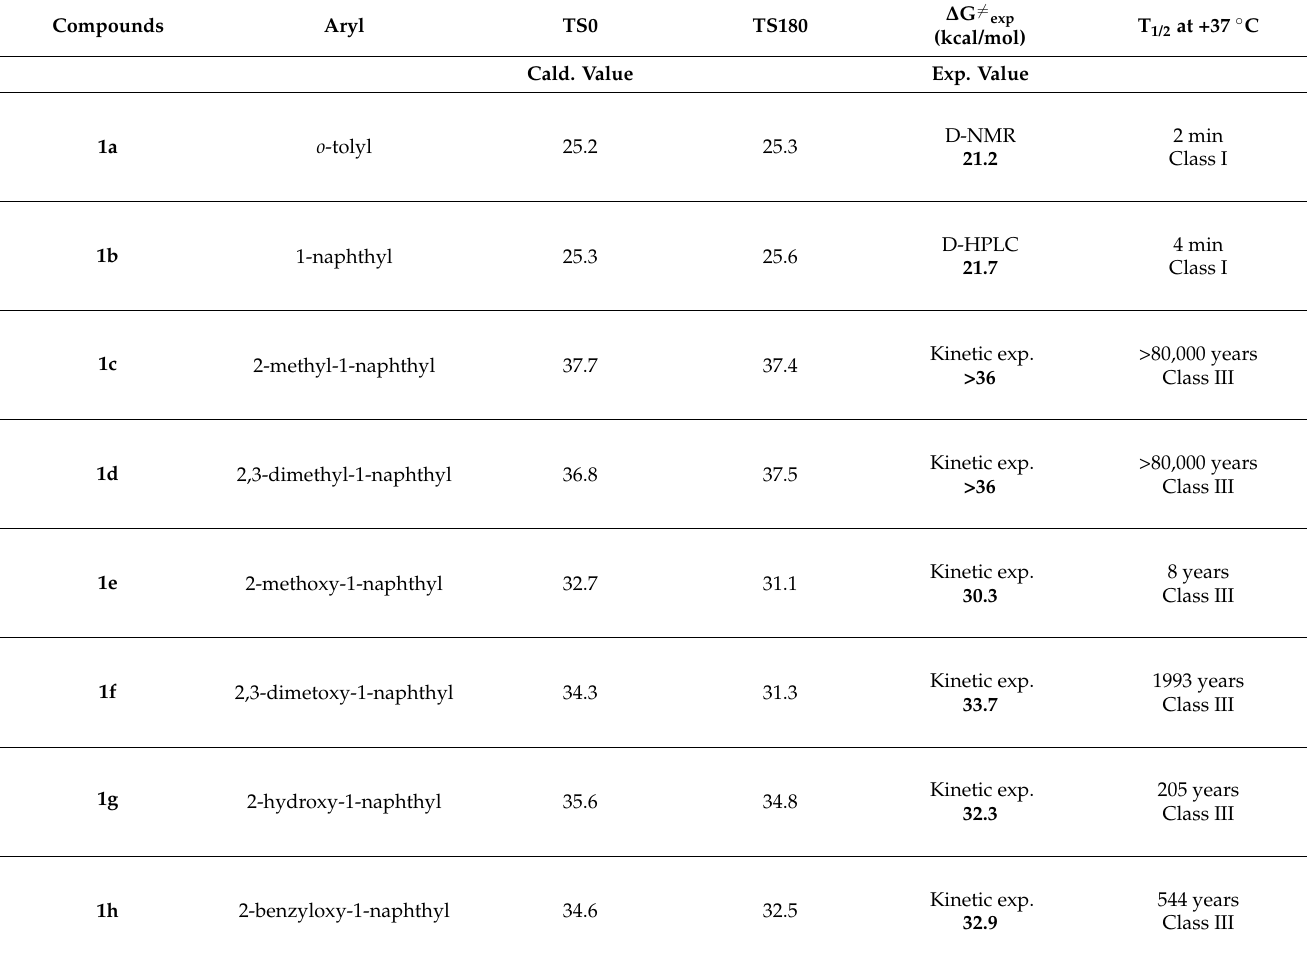
Table 1. Calculated energies (kcal/mol in the gas phase) of TS and experimental ∆ G (cid:54) = of compounds 1a–1h at the B3LYP-D3/6–31G(d) with empirical dispersion. ZPE-corrected free energy has been reported. The experimental energy barriers were determined using the reported